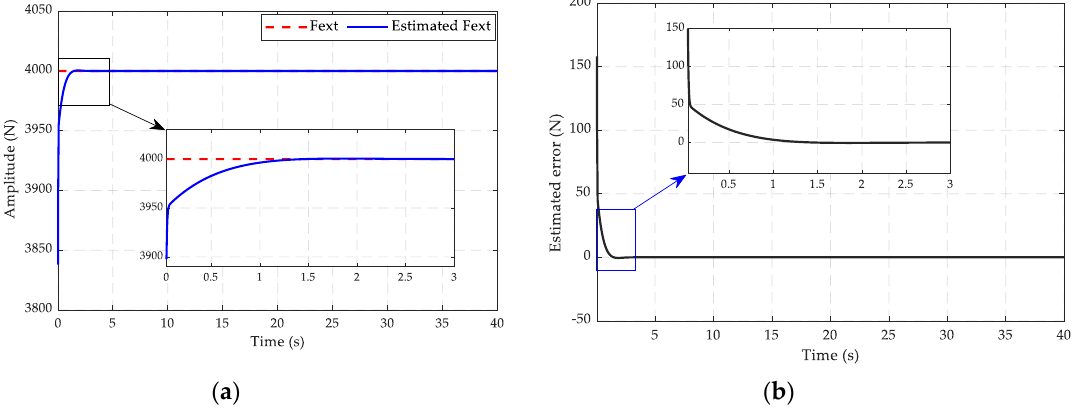
Figure 9. Comparison of estimated external force. ( a ) Estimated result. ( b ) Estimated error.